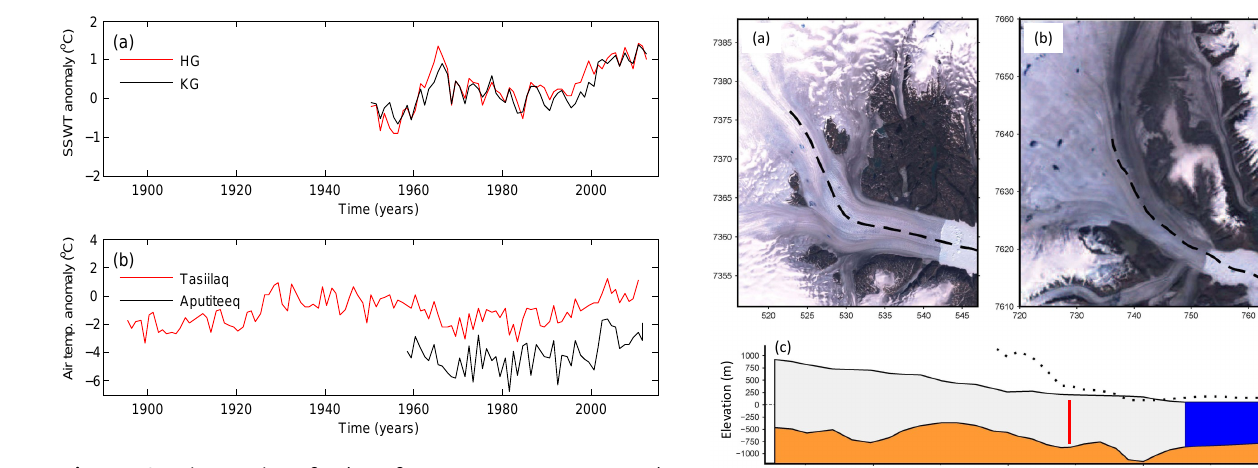
Figure 10. Time series of sub-surface water temperature, and air temperature. (a) SSWT anomaly in degrees Celsius at 315m depth at point 1 (near Helheim Glacier – HG) and point 2 (near Kangerdlugssuaq Glacier – KG) (see Fig. 1a for locations), with the mean temperature during 1981–2012 removed, (b) Air temperature anomaly in degrees Celsius at Tasiilaq and at Aputiteeq.